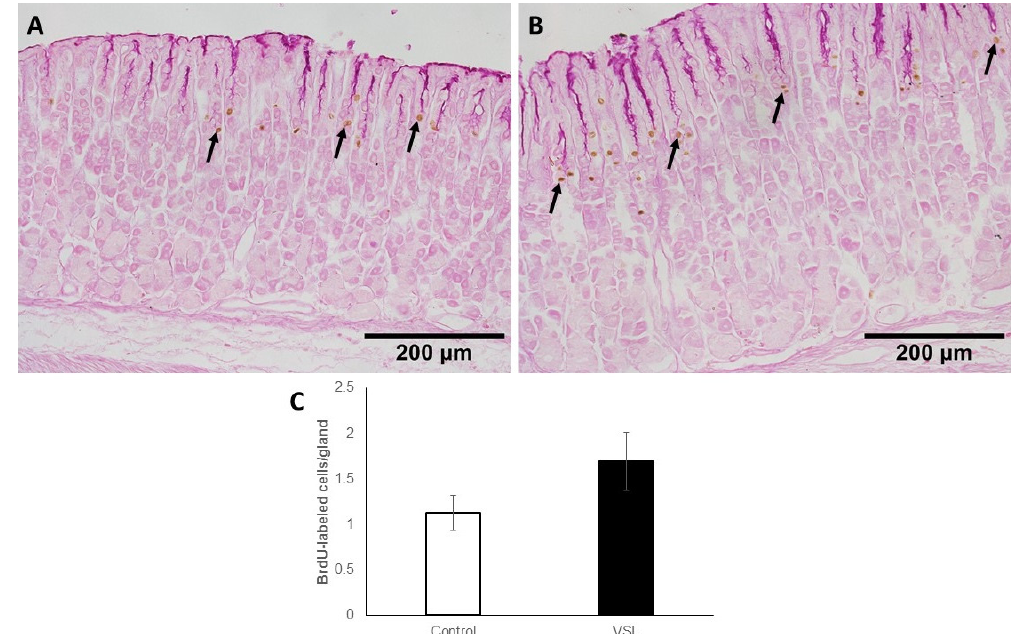
Figure 9. Immunohistochemical analysis of S-phase cells using anti-5 ′ -bromo-2 ′ -deoxyuridine (BrdU) antibody in the gastric mucosa of control ( A ) and VSL-treated ( B ) mice. Note that BrdU-labelled cells (brown nuclei) of VSL-treated tissues tend to appear more expanded when compared with control tissues and uniformly distributed in most of the glands. Magnification bar = 200 µm. Analysis of BrdU-labeled cell counts per gland in the mucosa of seven control and seven VSL-treated mice are presented as mean ± SE ( C ). No significant difference was found between VSL and control tissues.